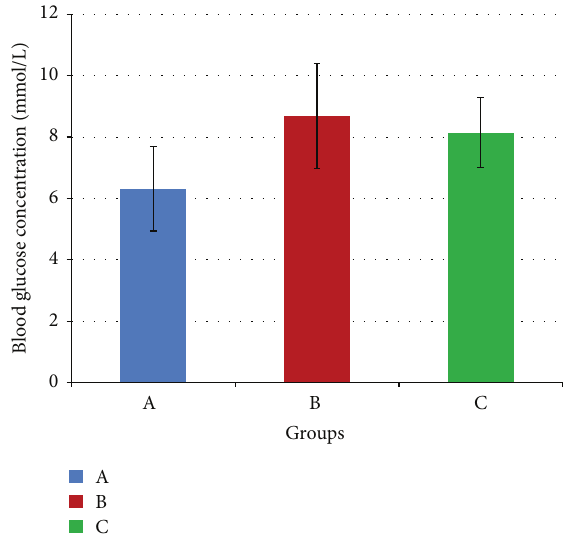
Figure 4: Mean blood glucose concentrations of rats in groups A, B, and C at the end of the four-week treatment period. Group A: control (HSD/HFD); group B: stress + HSD/HFD; group C: stress + GA + HSD/HFD. Abbreviations: GA: glycyrrhizic acid, HSD: high- sucrose diet, and HFD: high-fat diet.